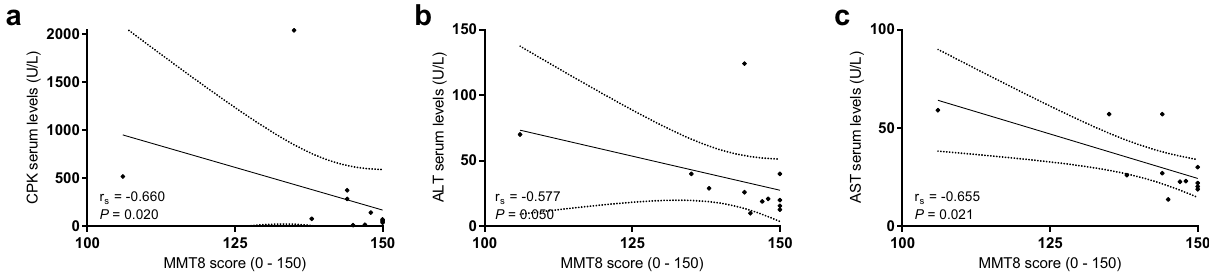
Figure 1. Correlation between muscle damage and muscle weakness markers. ( a ) serum levels of CPK and MMT score; ( b ) ALT serum levels and MMT8 score; ( c ) serum levels of AST and MMT8 score. MMT8 Manual Muscle Testing 8; CPK creatine phosphokinase; ALT alanine aminotransferase; AST aspartate